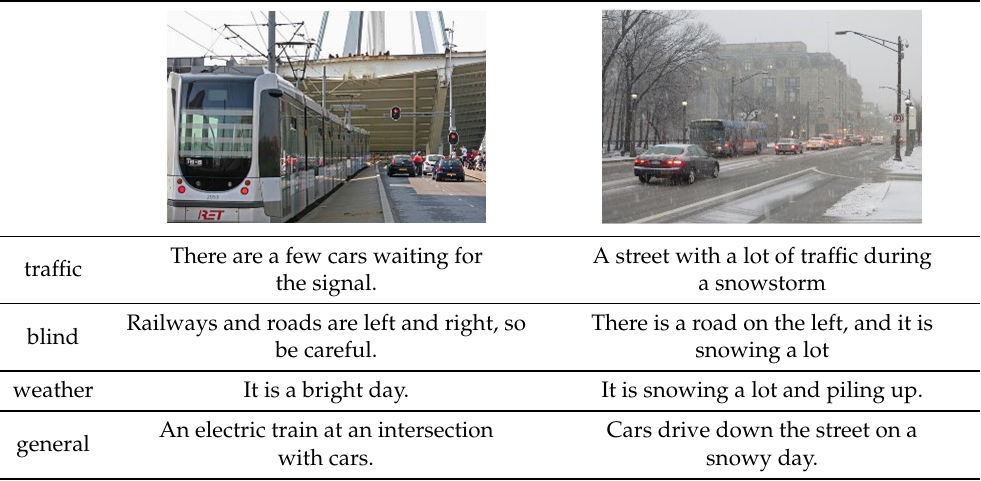
Table 1. Example of a contextual caption in a